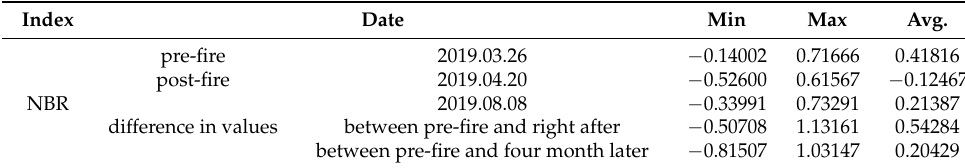
Table 4. Result of NBR pixel